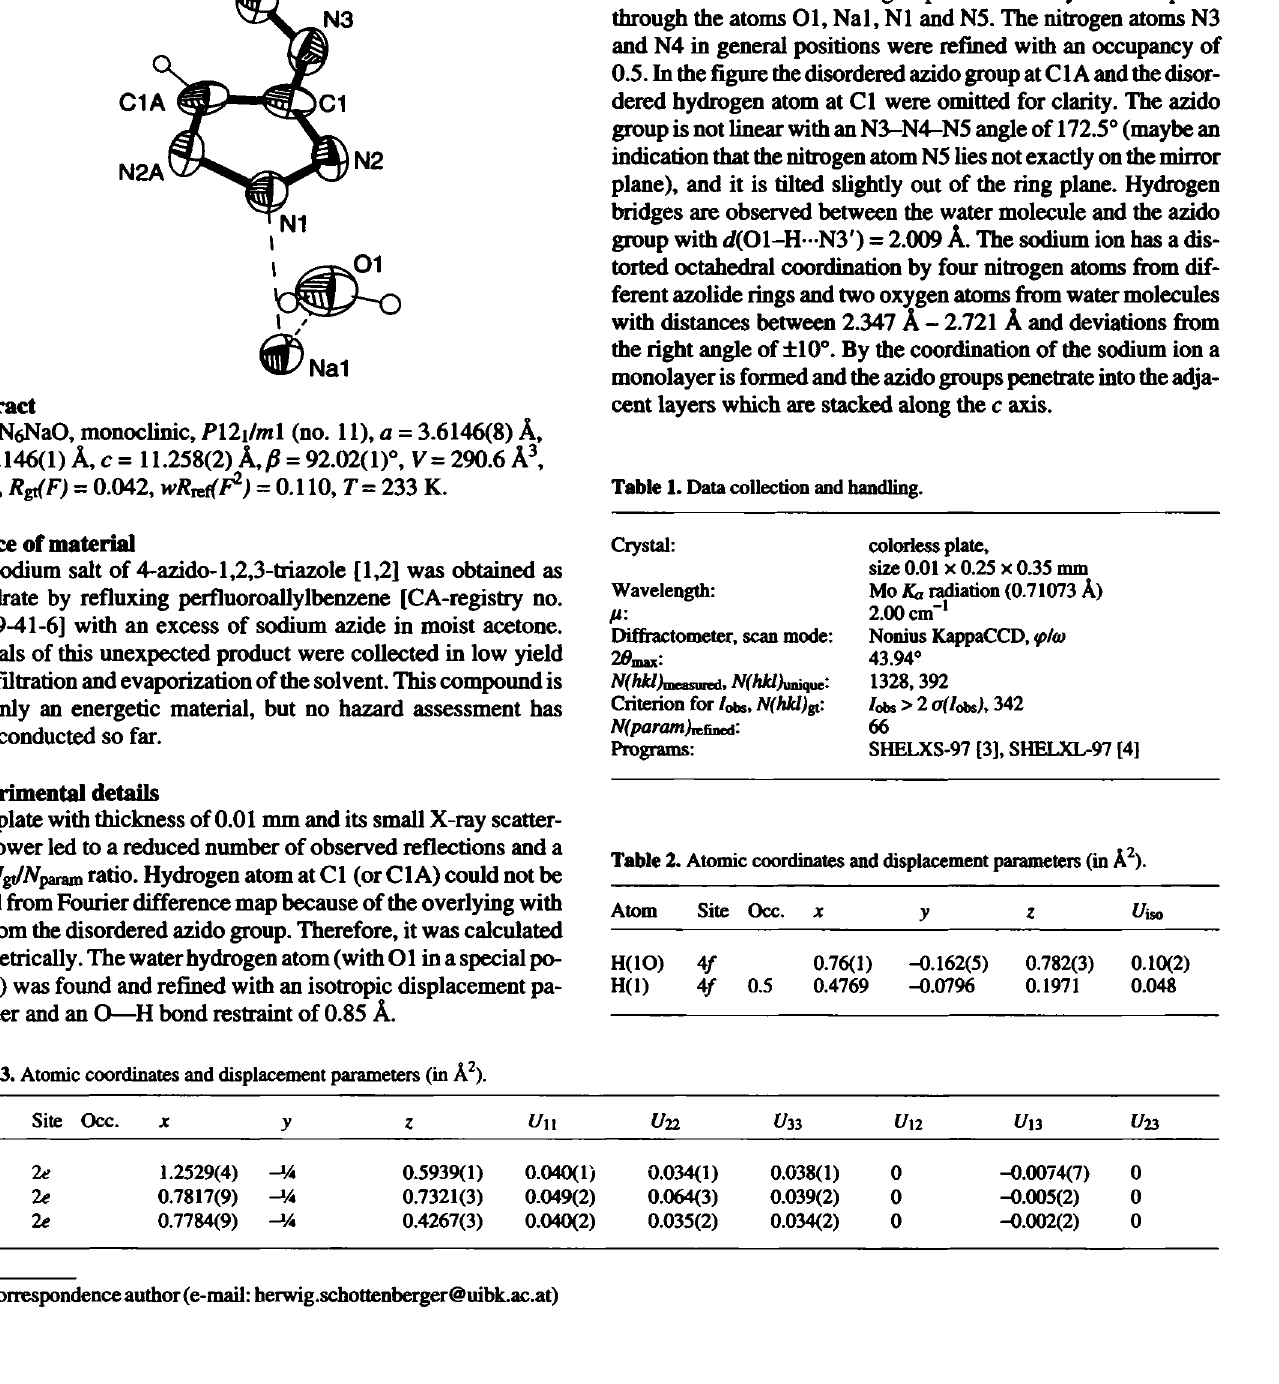
Table 2. Atomic coordinates and (j lisplacement pi irameters (in A 2 ).